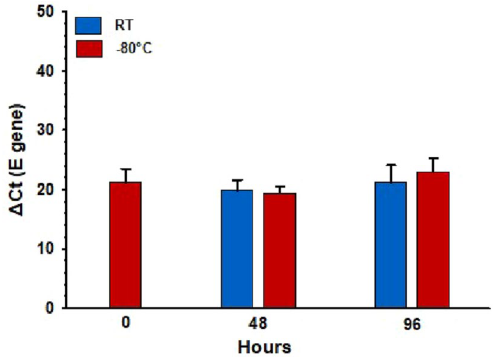
Figure 4. Effect of incubation time at room temperature (RT) and − 80 °C on the detection of SARS-CoV-2 RNA E gene. No significant difference was observed between incubation at RT versus − 80 or between different incubation times ( P ≥ 0.293). ΔCt: delta cycle threshold in RT-qPCR test. Bars represent the mean and error bars indicate the standard